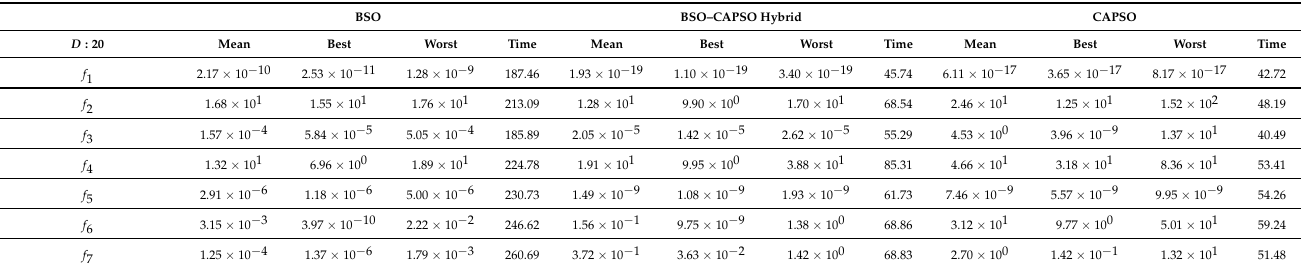
Table 4. Simulation results for D = 20.